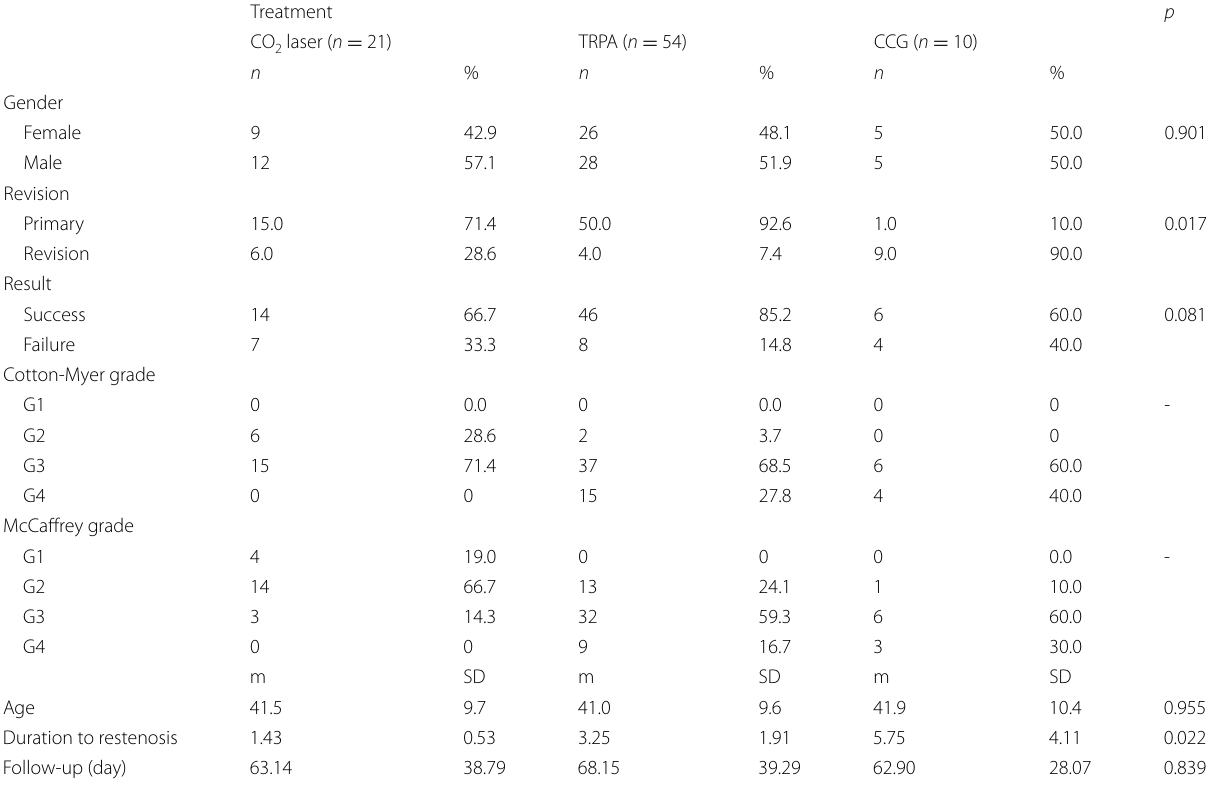
TRPA tracheal resection with primary anastomosis, CCG costal cartilage